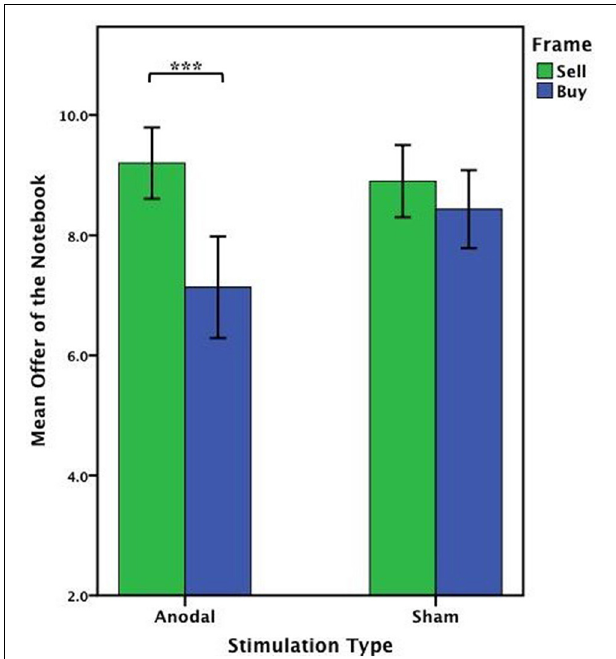
FIGURE 10 | Data of offer of the notebook (Experiment 2). The mean offer of the notebook across anodal or sham stimulation in each frame. Error bars indicate 95% confidence intervals. Asterisks indicate statistically significant difference between WTA and